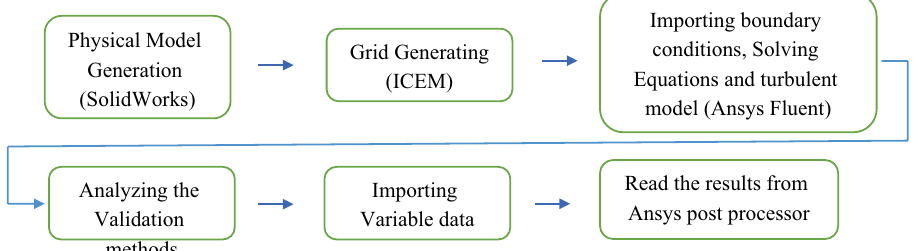
Fig. 2 Method of Numerical Section Flow